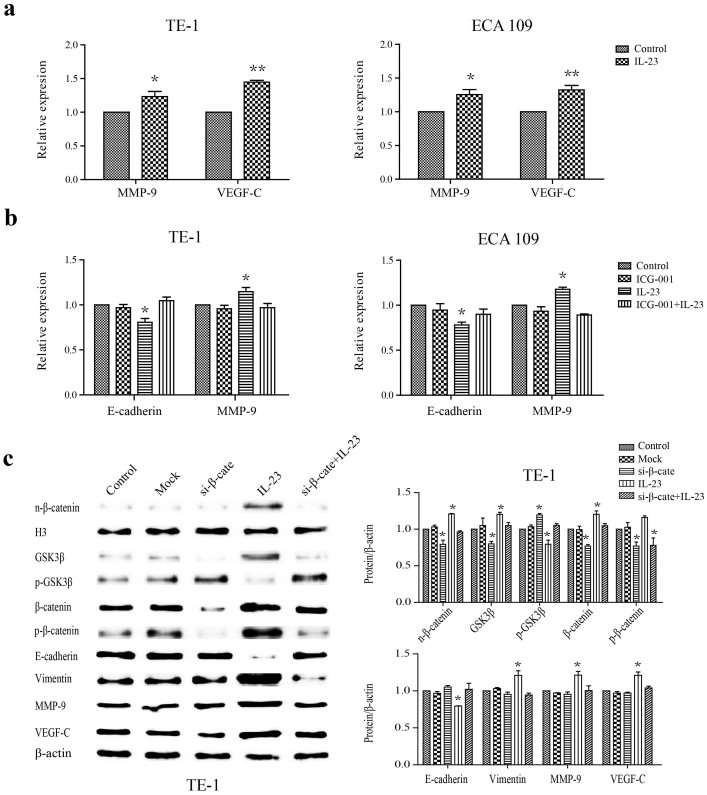
The expressions levels of Wnt/β-catenin and metastasis related-proteins in OSCCs treated with IL-23.(a) Effect of IL-23 on MMP-9 and VEGF-C expression: TE-1 and ECA 109 cells were treated with IL-23 (50 ng/ml) for 24 h. The supernatants were then collected for ELISA analysis. (b) The mRNA levels of E-cadherin and MMP-9 after treatment with ICG-001 (5 μM) and/or IL-23 (50 ng/ml); (c) Western blotting results showing the changes in n-β-catenin, GSK3β, p-GSK3β, β-catenin, p-β-catenin, E-cadherin, vimentin, MMP-9 and VEGF-C expression levels in TE-1 cells treated with IL-23 (50 ng/ml) for 24 h andβ-catenin silencing. Histone H3 andβ-actin were used as protein loading controls. Statistical results are presented as the means ± SEM (n = 3) based on ANOVA followed by the Tukey-Kramer test. Quantitative analysis of panels is showed in the bar chart. Experiments were repeated at least three times with similar results, and only one representative result is shown. Mock: transfection with lipofectamine 2000 without siRNA, si-β-cate: siRNA β-catenin, n-β-catenin: nuclear β-catenin, p-GSK3β: phospho-GSK3β, p-β-catenin: phospho-β-catenin, H3: Histone H3. *p < 0.05, **p < 0.01.